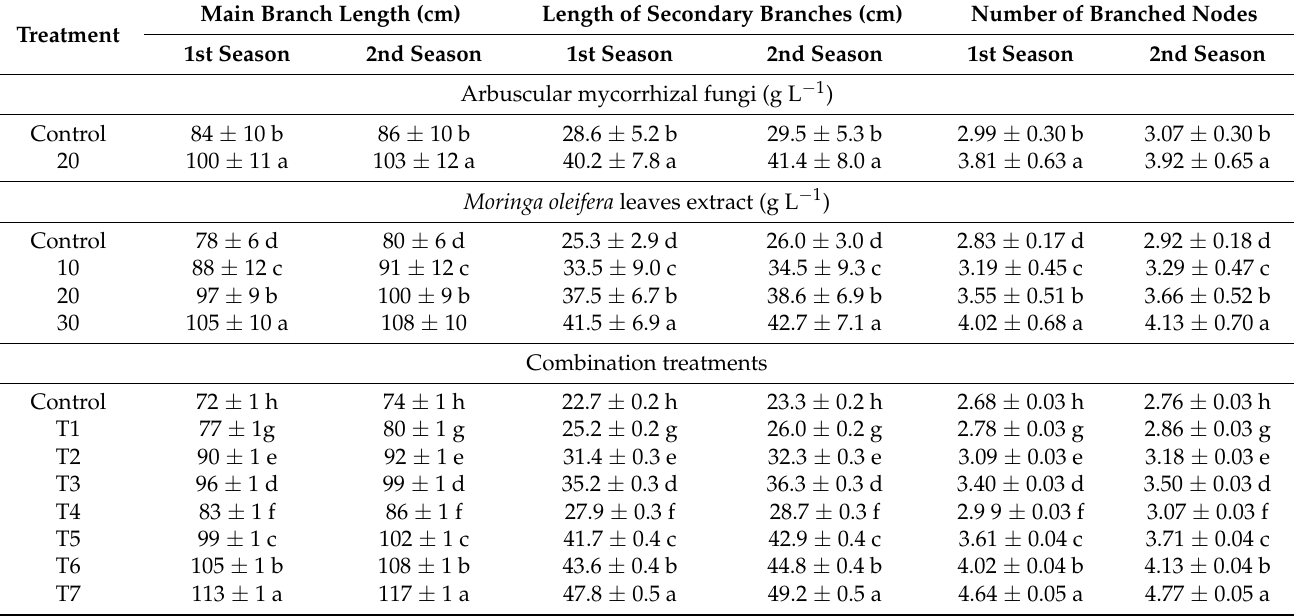
Table 5. The mean values of the main branch length (cm), length of secondary branches (cm) and number of branched nodes of jojoba shrubs affected with ground inoculation of arbuscular mycorrhizal fungi and foliar application of Moringa oleifera leaves extract, as well as their combination treatments in both seasons of the study.